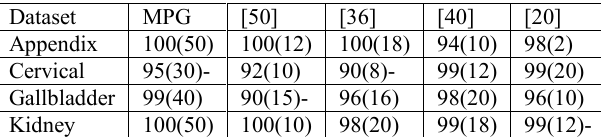
Table 3. Parameters for proposed technique for classification of genes data sets